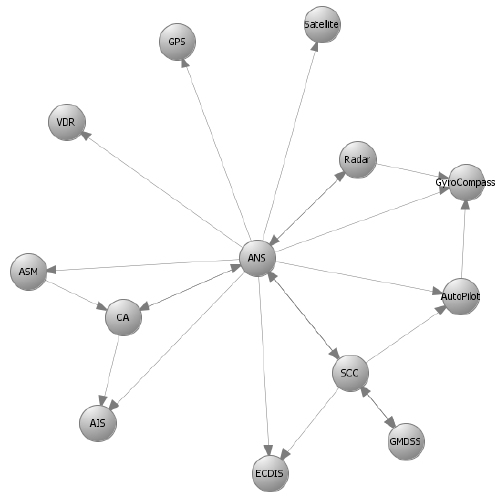
( V , E ) –Information flows. I